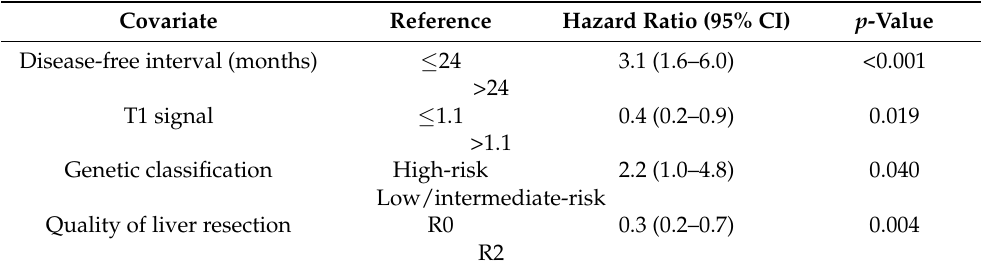
Table 2. Multivariate Cox proportional hazards analysis of overall survival.